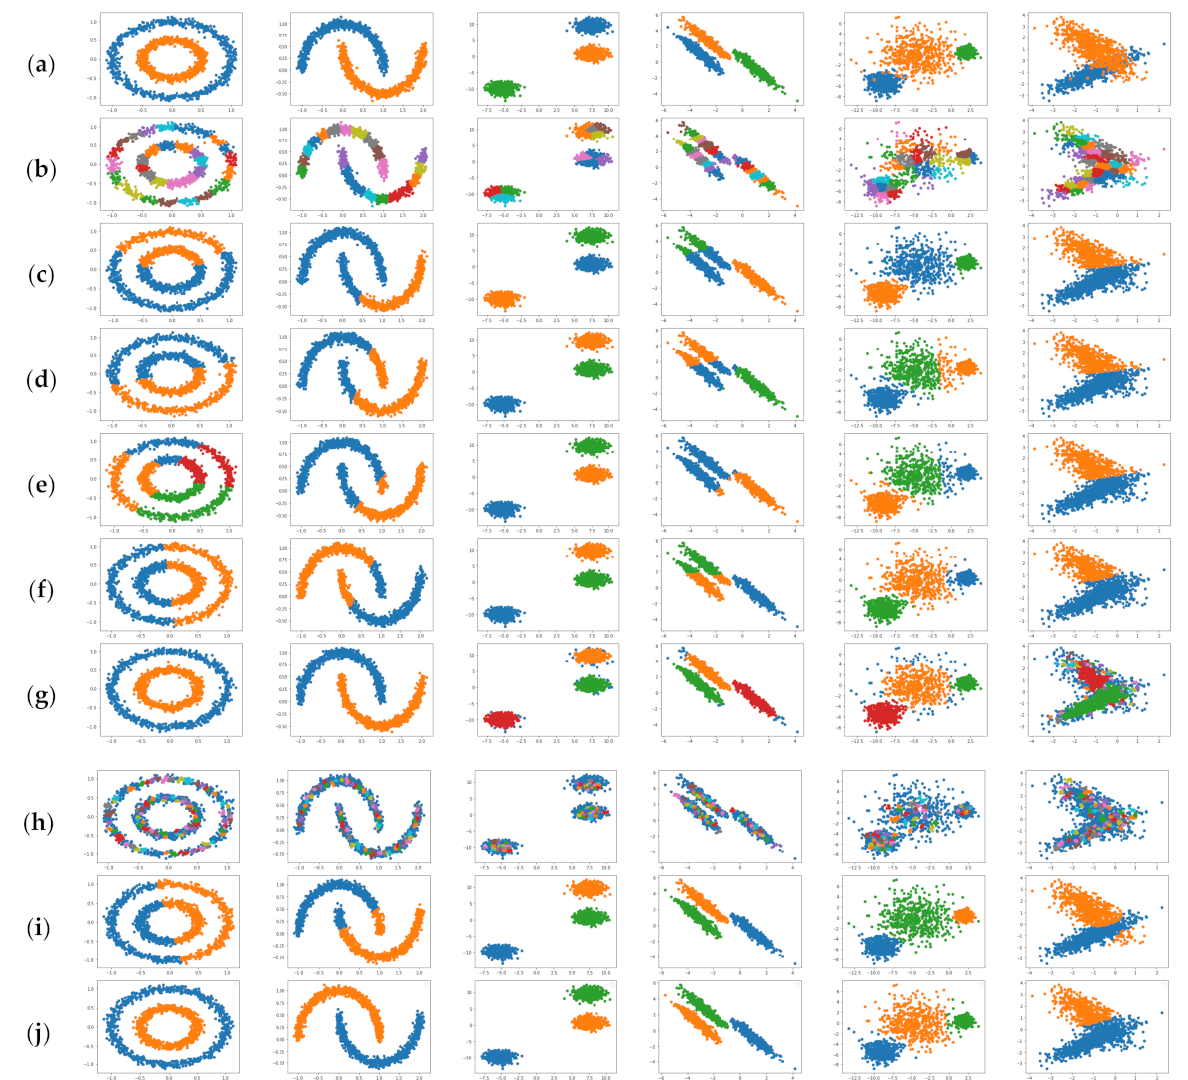
Figure 10. Visual result of each clustering method on each dataset: ( a ) ground truth, ( b ) affinity propagation, ( c ) agglomerative hierarchical, ( d ) k-means, ( e ) mean-shift, ( f ) spectral, ( g ) DBSCAN, ( h ) OPTICS, ( i ) Gaussian mixtures, and ( j ) the proposed clustering methods. Left to right: noisy circles, noisy moons, blobs, anisotropic, varying variance, and overlapping